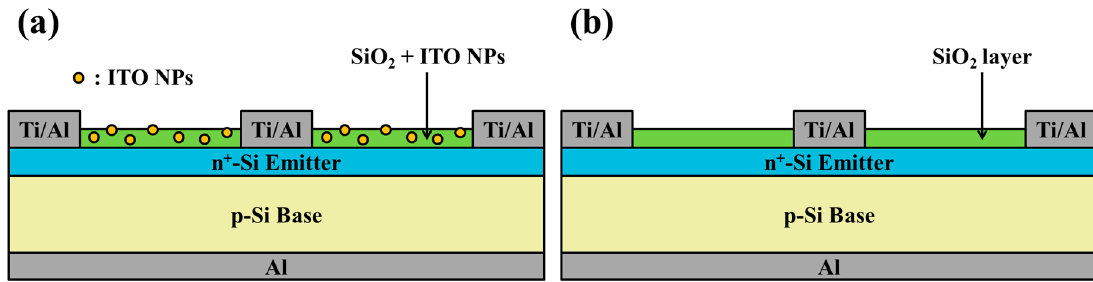
Figure 2. Schematic diagram showing ( a ) a cell with ITO-NPs dispersed in a layer of SiO 2 (250 nm), ( b ) a cell with a layer of SiO 2 (250 nm) that did not contain ITO-NPs.